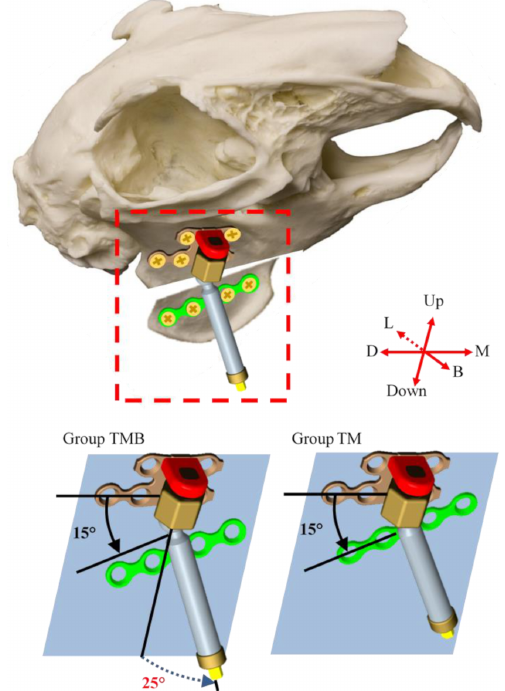
Figure 2. The distractor placement illustration defined that the multi-axial alveolar distractors were designed to fix at the right mandibular of the experimental rabbits. The distractor direction was adjusted 15 ◦ toward the mesial side and 25 ◦ to the buccal side in Group TMB ( n = 3) and 15 ◦ toward the mesial side in Group TM ( n =